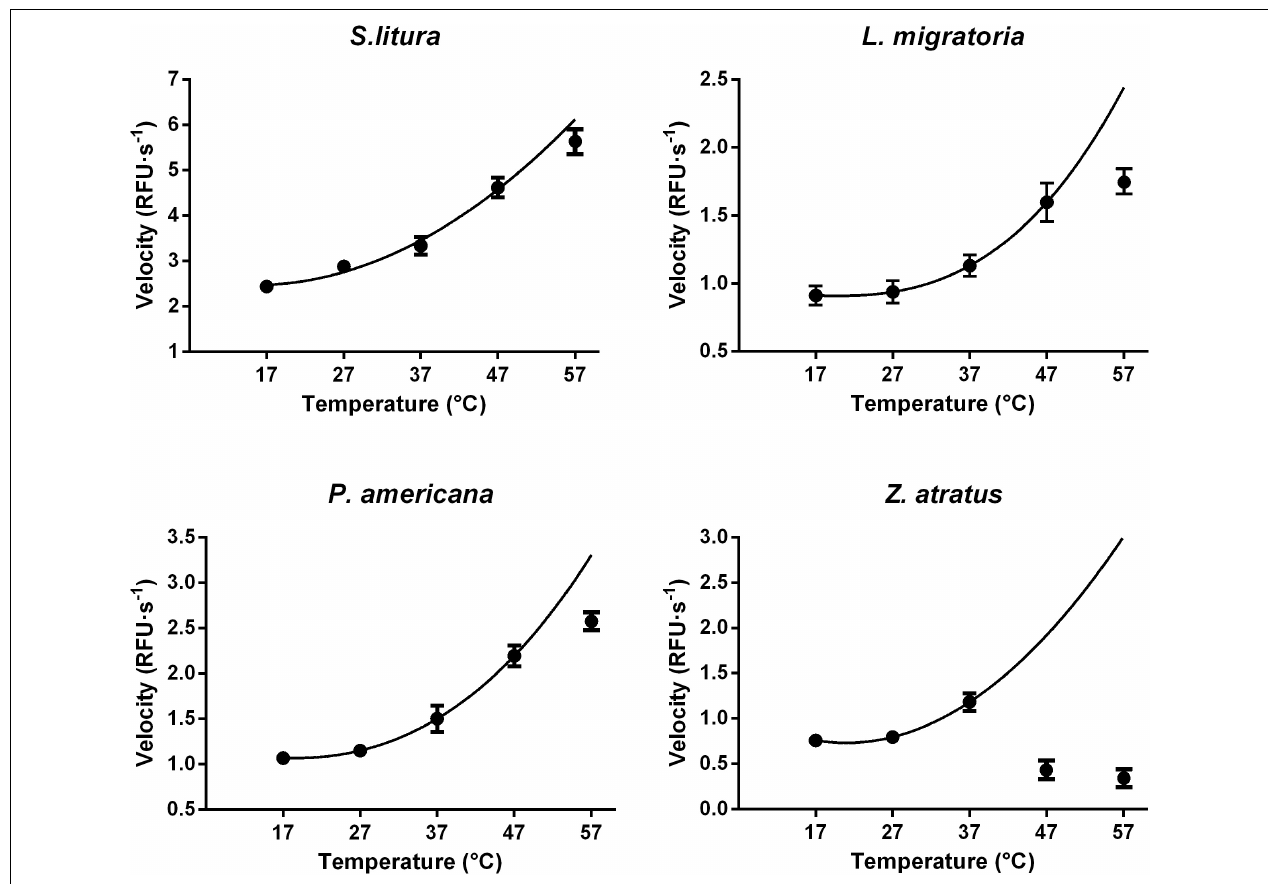
FIGURE 7 | Distinct impacts of temperature on the dsRNA degrading nucleases of four insects. The homogenates were prepared from whole body of different insects. The test reaction used the buffer with optimal pH and Mg 2 + concentrations for different insect species (pH 10.0 and 8 mM Mg 2 + for S. litura , pH 9.0 and 8 mM Mg 2 + for the other three species). Each reaction containing 19 µ L enzyme solution and 1 µ L fluorescence labeled dsRNA substrate at a final concentration of 0.5 µ M. The fluorescence intensity in different reactions were continuously monitored at different temperatures. Values are mean ± SE; n =